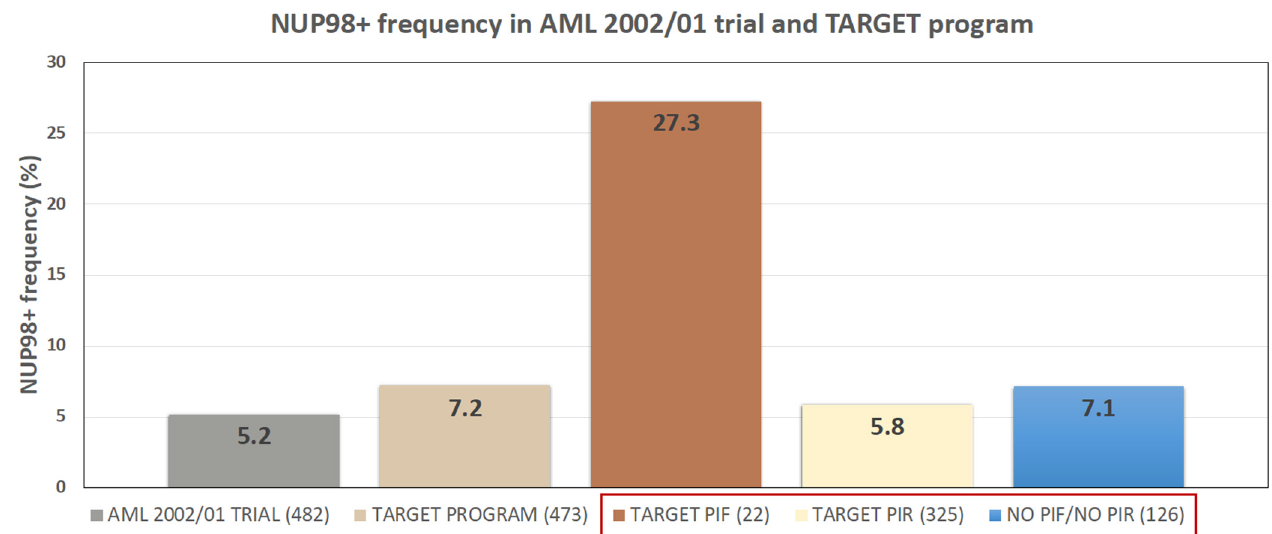
Figure 1. NUP98r frequency in AIEOP AML 2002/01 and TARGET program. The TARGET study distinguishes PIF from PIR patients. The three subgroups boxed in red are included in TARGET study.